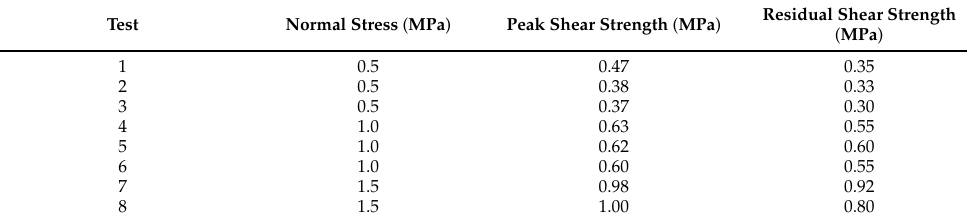
Table 2. Summary of the direct shear tests of samples with smooth surfaces.